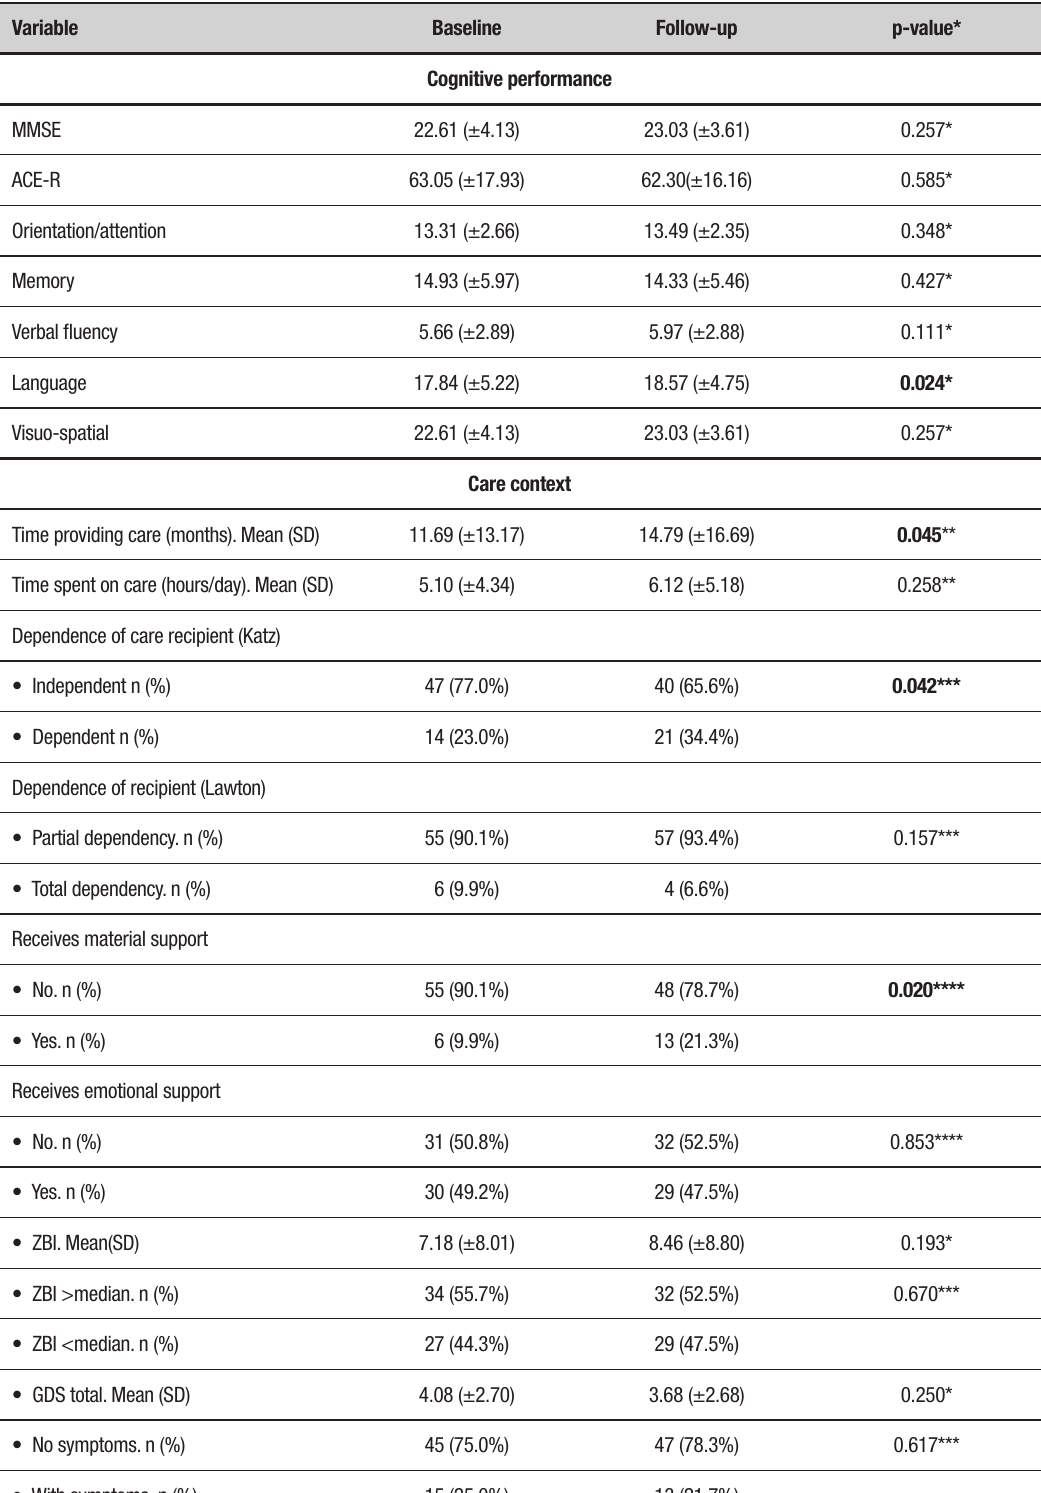
Table 1. Cognitive performance and variables of care context among elderly caregivers at both evaluations (n=61), São Carlos-SP, Brazil,